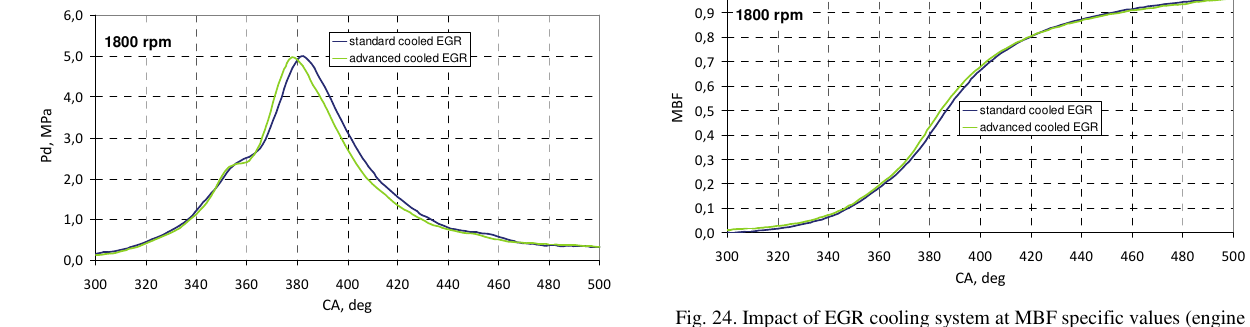
Fig. 21. Impact of EGR cooling system at differential pressure Pd (engine rotational speed:1800 rpm, 190 Nm load)